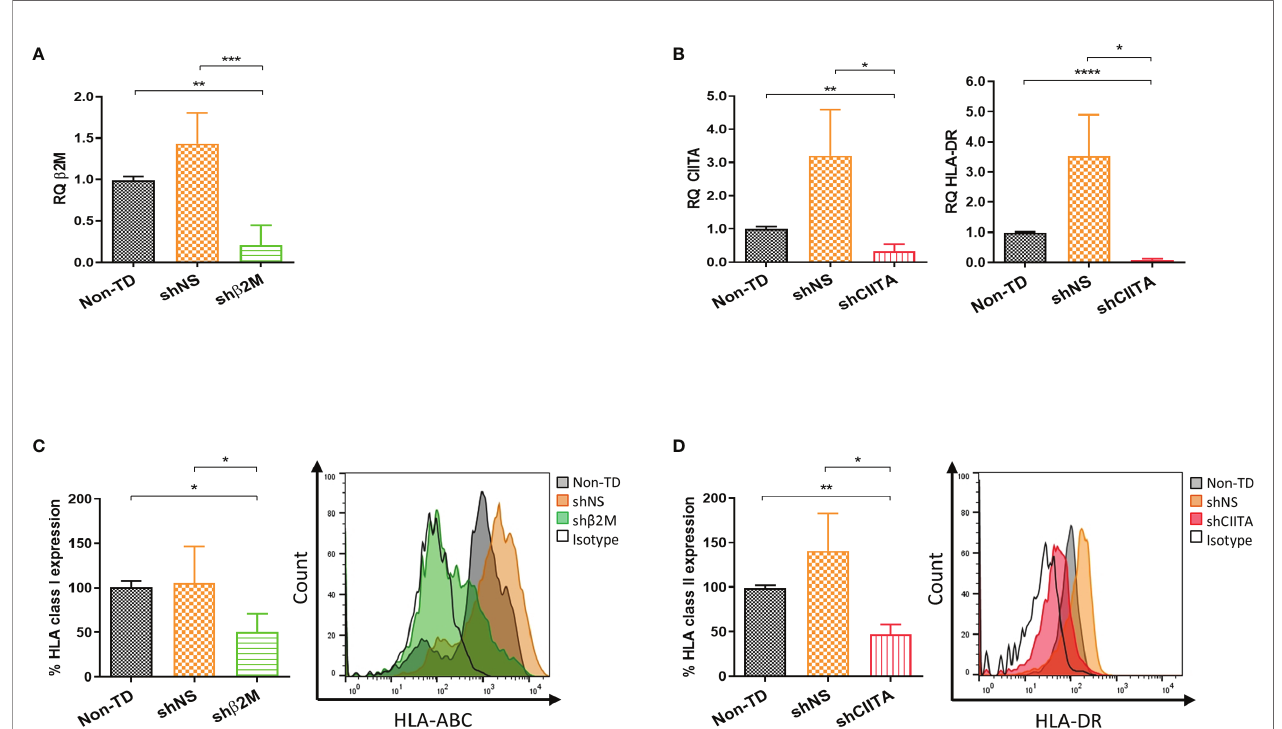
FIGURE 4 | Silencing HLA class I and II expression on limbal stem cells. (A, B) Real time analysis for transcripts levels of HLA class I and class II related molecules ( b 2-microglobulin ( b 2M), class II major histocompatibility complex transactivator (CIITA) and HLA-DR) of silenced (sh b 2M and shCIITA) and non-silenced (shNS and Non-TD) limbal stem cells (n=4) after 48 hours IFN g (100ng/mL) stimulation. (C, D) Mean expression of HLA class I and class II molecules on IFN g -stimulated limbal stem cells and representative overlay showing HLA class I and class II downregulation effect on transduced cells with sh b 2M and shCIITA vectors (n=5). Statistical signi fi cance was evaluated by one-way ANOVA and data are presented as mean ± SD, *p < 0.05, **p < 0.01, ***p < 0.001, ****p <